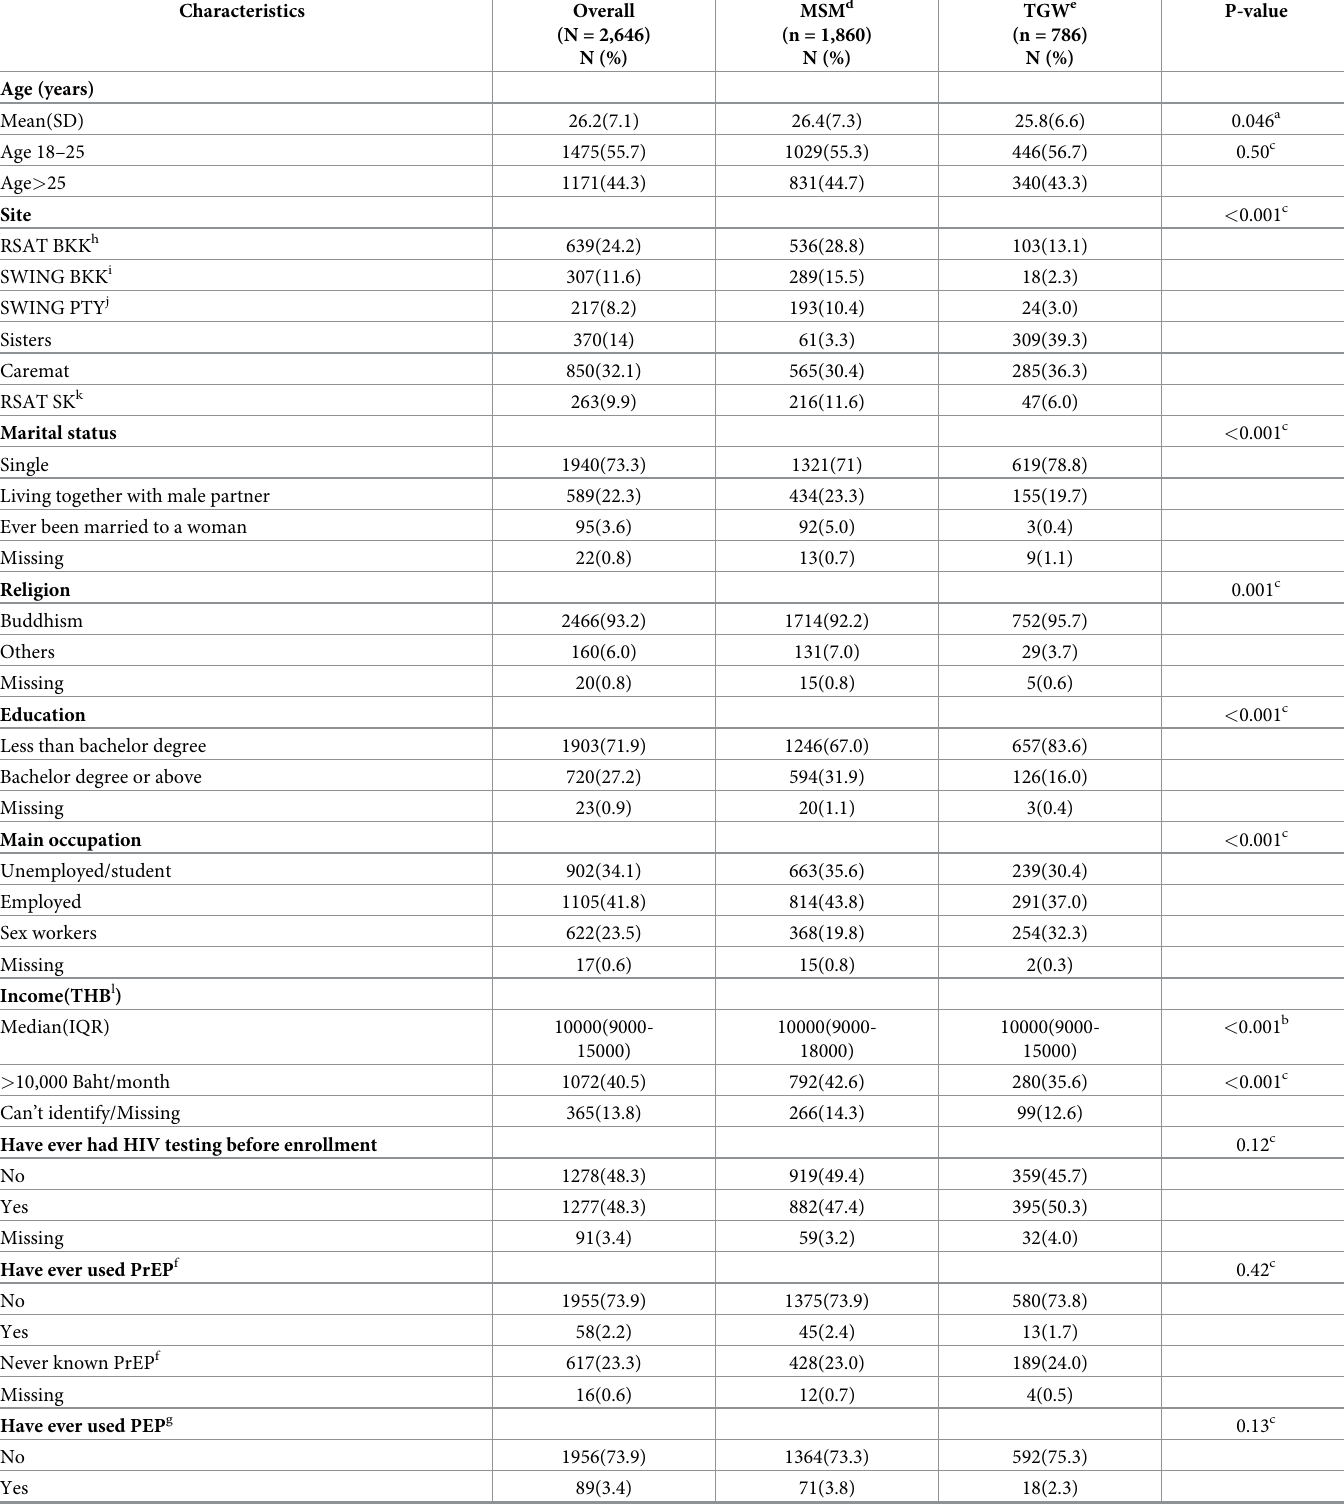
Table 1. Baseline demographic characteristics of MSM and TGW Participants.